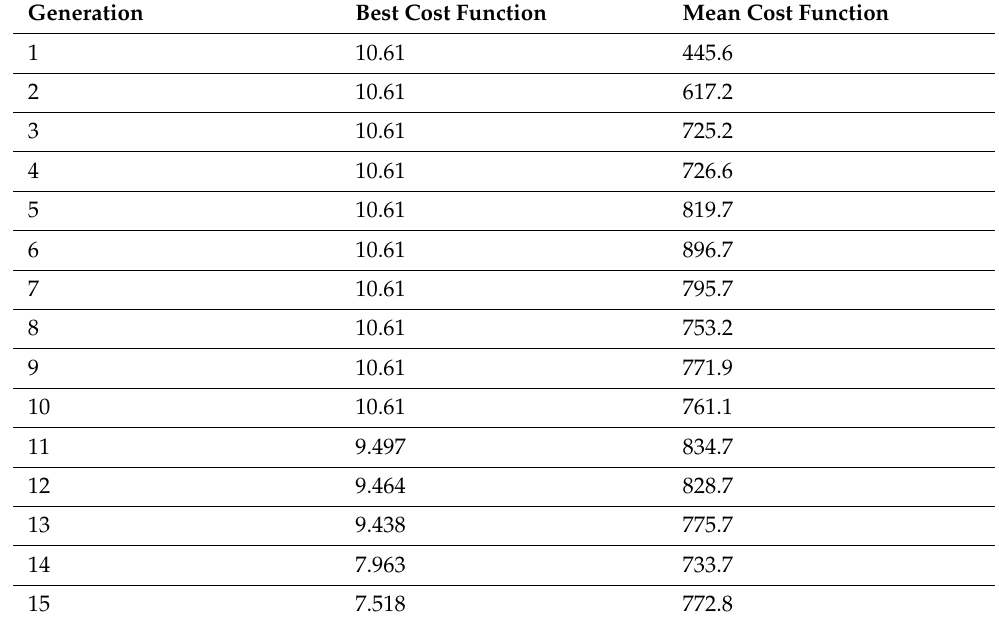
Table 1. The cost function process of the GA – ANN.